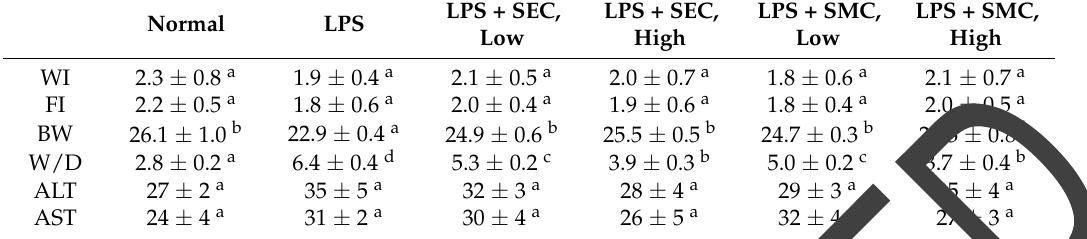
Table 1. Water intake (WI, mL/mouse/day), feed intake (FI, g/mouse/day), body weight (BW, g/mouse), lung W/D (wet/dry) ratio, plasma ALT (activity of alanine aminotransferase) or AST (aspartate aminotransferase) activity (U/mg protein) of mice in normal group, LPS (lipopolysaccharide) group, LPS + low SEC ( S -ethyl cysteine) group, LPS + high SEC group, LPS + low SMC ( S -methyl cysteine) group and LPS + high SMC group after 3-day treatments. Data are mean ± SD (standard deviation), n = 10. a–d Means in a row without a common letter differ, p < 0.05. LPS + SEC, LPS + SEC, Normal LPS Low